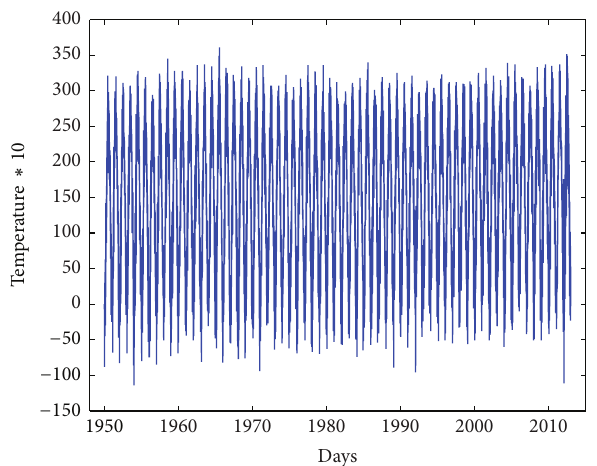
Figure 2: A segment of daily average temperature of